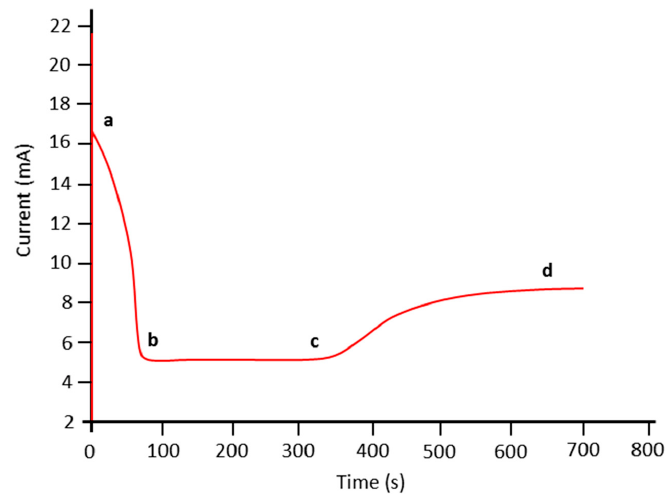
Figure 6. Current-time curve during PPy synthesis. Reproduced from [21]. Copyright (2017), with permission from Elsevier.